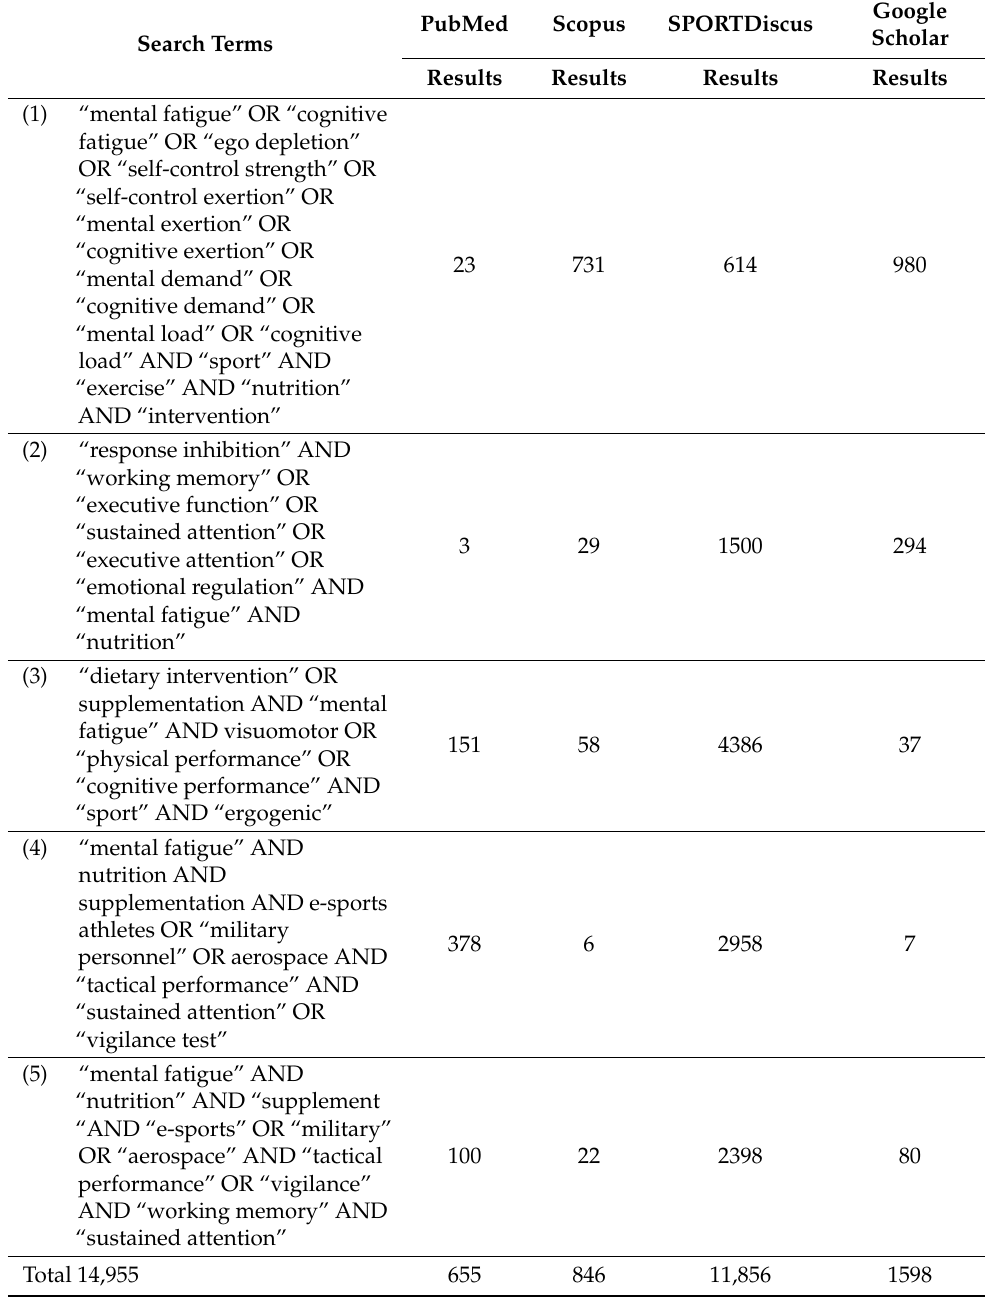
Table 1. Search terms and results before